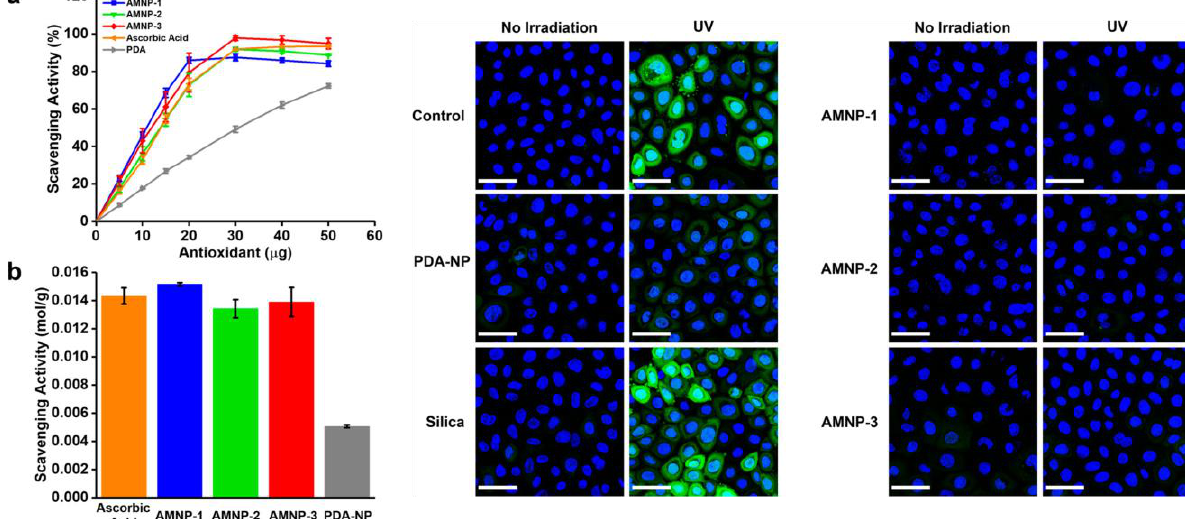
Figure 4. Radical scavenging by AMNPs compared to that of PDA-NPs and ascorbic acid. ( a ) DPPH radical scavenging activity of antioxidants; ( b ) calculated amount of quenched DPPH per gram of antioxidant. Oxidative stress was assessed via the ROS-activated CM-H2DCFDA dye (green). NHEK cells were incubated for 3 days with 0.02 mg/mL of AMNP-1, -2, and -3, PDA-NPs, silica NP, or the vehicle (water), treated with the dye, subjected to UV irradiation, and imaged live. Nuclei were stained with Hoechst (blue). Reprinted with permission from ref. [103].